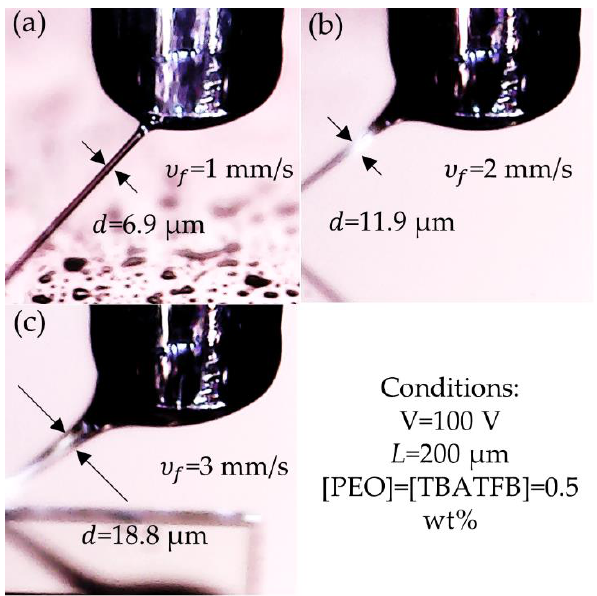
Figure 7. Effect of the velocity of the stage on the diameter of the polymer jet: ( a ) v f = 1 mm·s − 1 , ( b ) v f = 2 mm·s − 1 , and ( c ) v f = 3 mm·s − 1 .